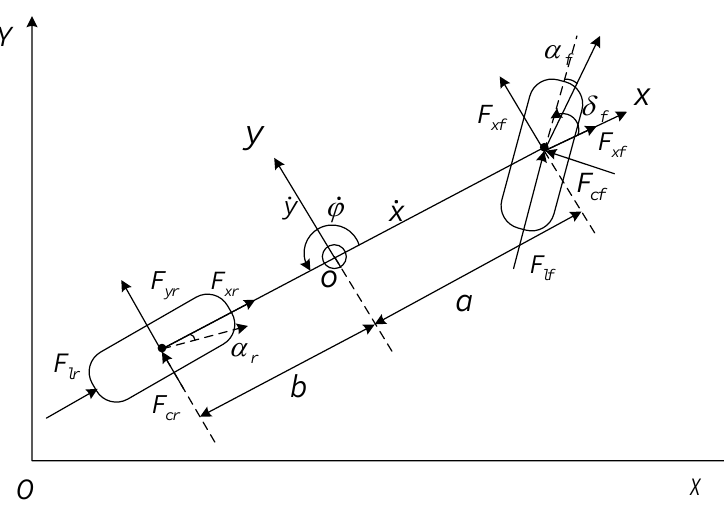
Figure 3. Three-degree-of-freedom dynamics model of vehicle. According to Newton’s second law for the x -axis and y-axis and the balance of mo- ments around the z-axis, we get Equation (1):